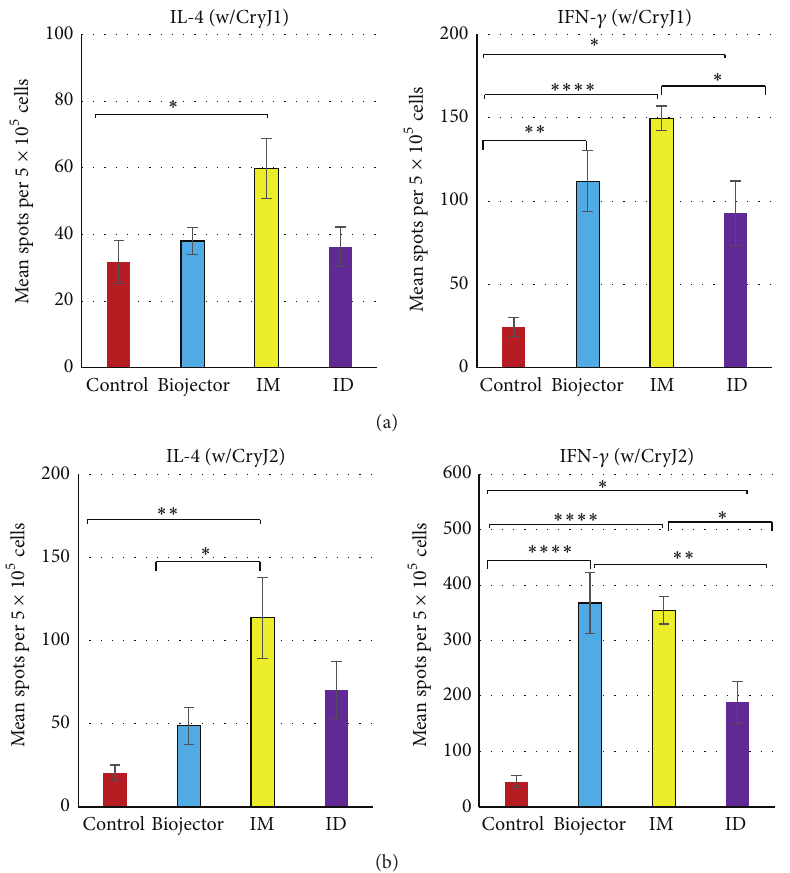
Figure 3: CryJ1-LAMP and CryJ2-LAMP Vaccines induce a strong Th1 cellular response. Vaccination protocol is described in Figure 2. At the end of study, freshly isolated splenocytes were treated with 1 𝜇 g/mL CryJ1 (a) or CryJ2 (b) protein for 48 hours. IL-4 and IFN- 𝛾 production were detected by ELISPOT. All data are shown as mean ± SEM. ∗ 𝑝 < 0.05 , ∗∗ 𝑝 < 0.01 , and ∗∗∗∗ 𝑝 < 0.0001 .